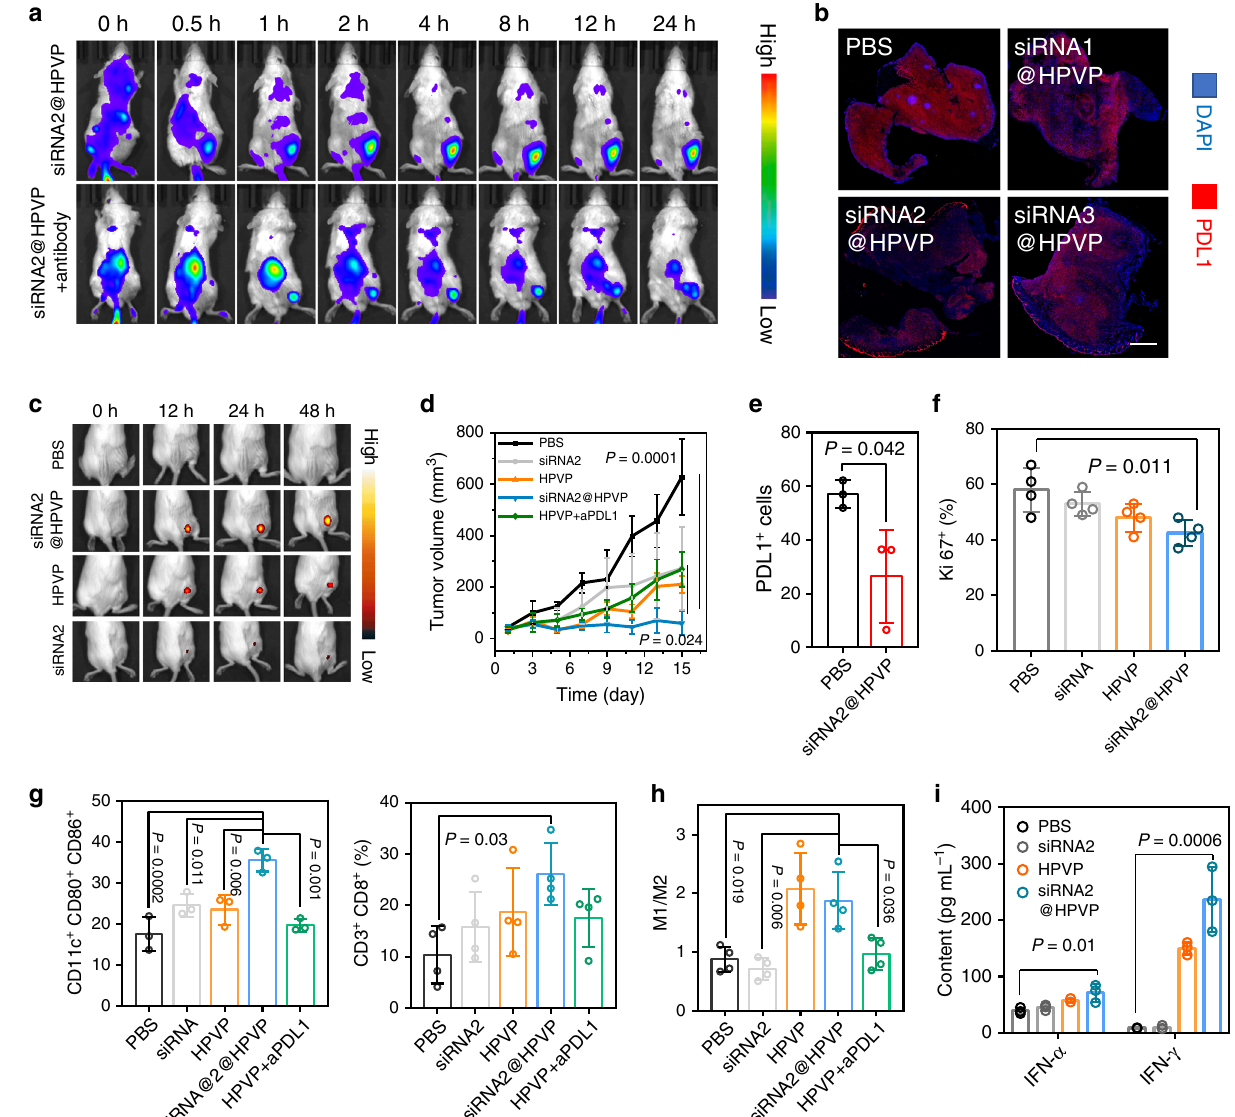
Fig. 3 Tumor accumulation and anticancer ability of siRNA2@HPVP. a In vivo tumor-targeting capacity of HPVP on 4T1 tumor-bearing mice after i.v . injection. The blockade of α 6 integrin with antibody reduced the tumor accumulation of HPVP. A representative image of three biological replicates is shown. b Ex vivo immuno fl uorescence images for the evaluation of PDL1 inhibition effect of siRNA1@HPVP, siRNA2@HPVP, and siRNA3@HPVP